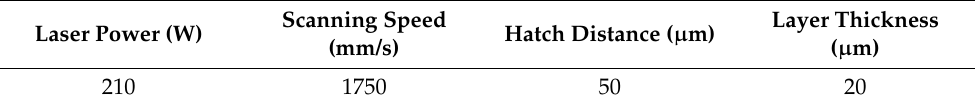
Table 1. Optimized laser powder bed fusion process parameters used in this study. Scanning Speed Laser Power (W) (mm/s)